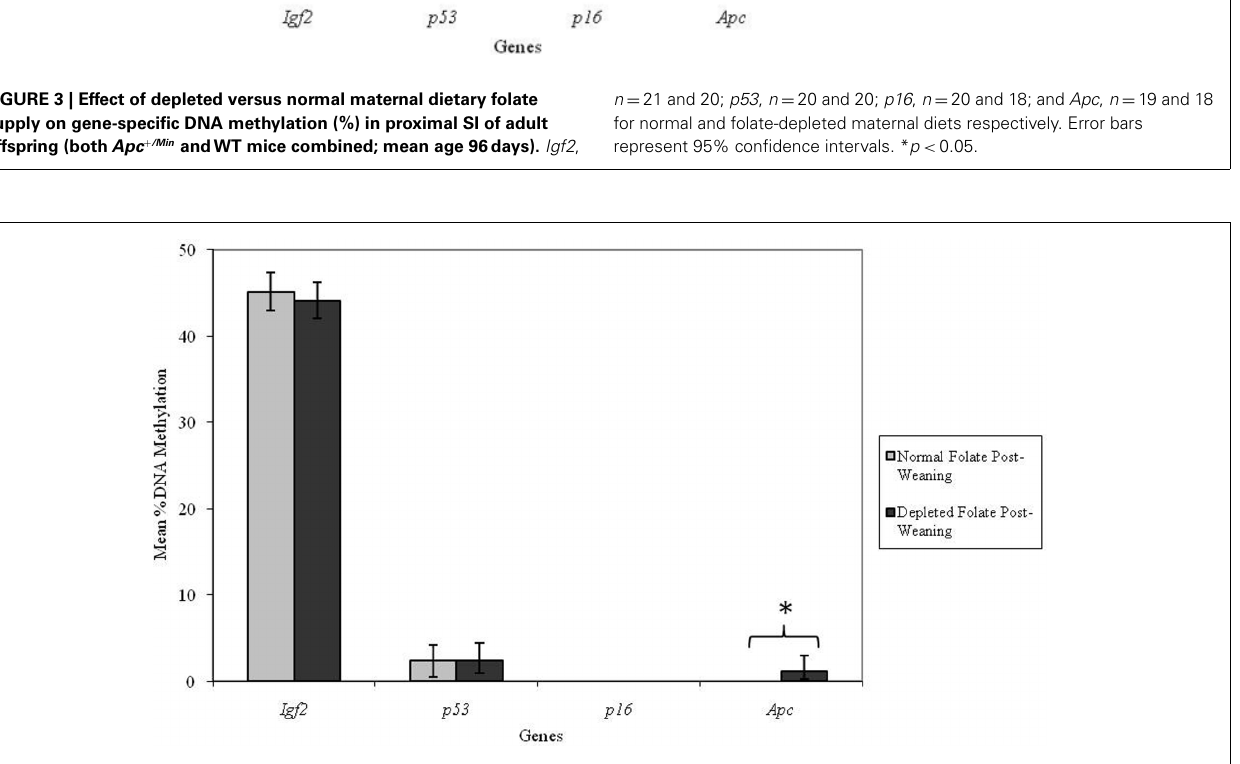
FIGURE 4 | Effect of dietary folate supply from weaning on gene-specific DNA methylation (%) in proximal SI of adult offspring (both Apc + /Min andWT mice combined; mean age 96days). Igf2 , n = 21 and 20; p53 ,